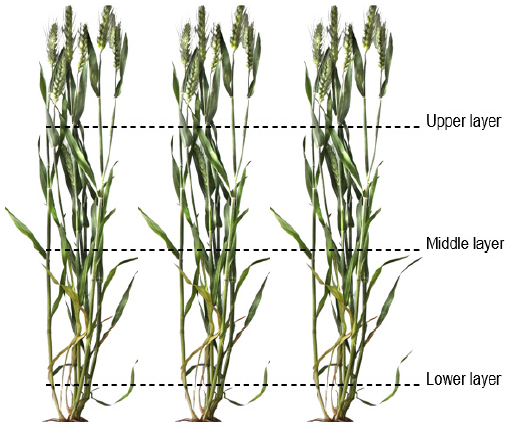
Figure 3. Triticum aestivum canopy stratification.